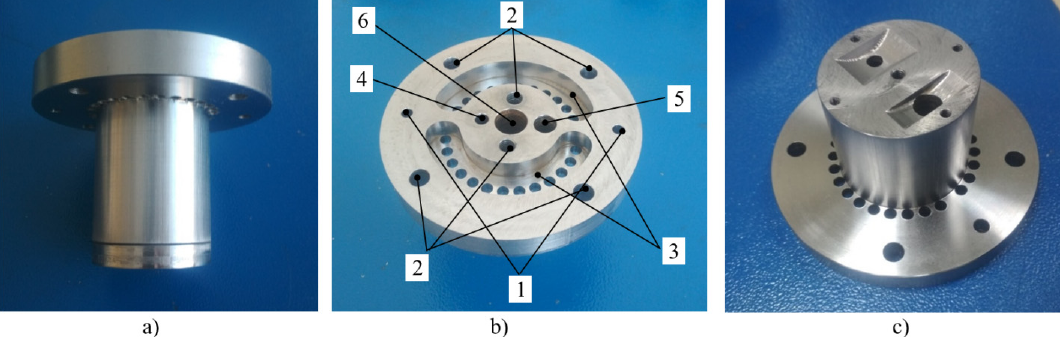
Figure 6. Inner cylinder: ( a ) assembled with the valve body, ( b ) top view, ( c ) bottom view. 1—holes for positioning pins; 2—fixation holes; 3—holes into the pump section; 4—channel to the discharge valve of the compressor section; 5—channel to the suction valve of the compressor section; 6—hole for assembling the instant pressure sensor in the compressor section.